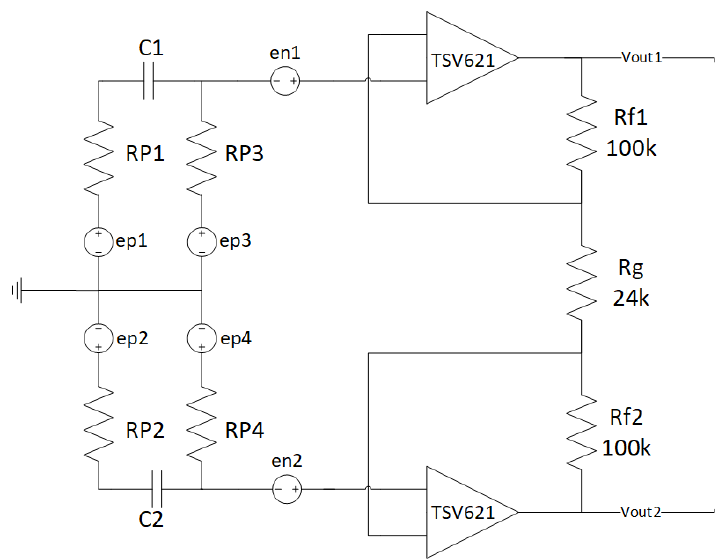
Figure 5. Noise analysis of the proposed pre-amp stage with Zep = ∞.